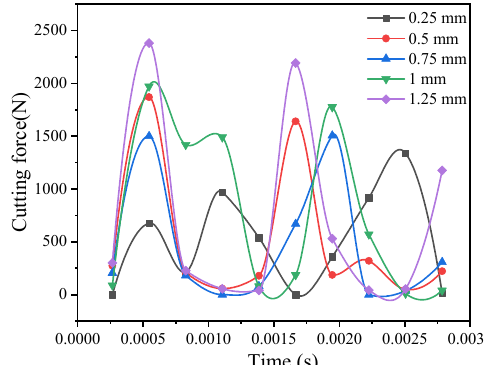
Figure 3. Cutting force curves at different milling depths.